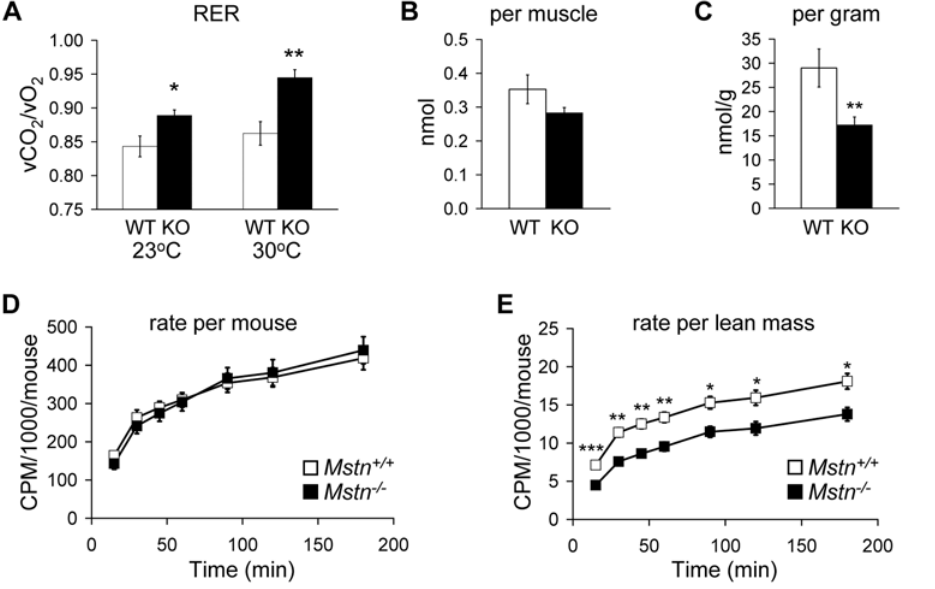
Figure 1. Substrate utilization in Mstn + / + and Mstn 2 / 2 mice on standard chow. ( A ) Total respiratory exchange ratio determined by indirect calorimetry. ( B ) Amount of palmitate oxidized per soleus muscle. ( C ) Amount of palmitate oxidized by soleus muscle normalized to soleus mass. ( D ) Rate of oleic acid oxidation per mouse. ( E ) Rate of oleic acid oxidation normalized to lean mass. n =6–10. * P , 0.05, ** P , 0.01, *** P , 0.001.